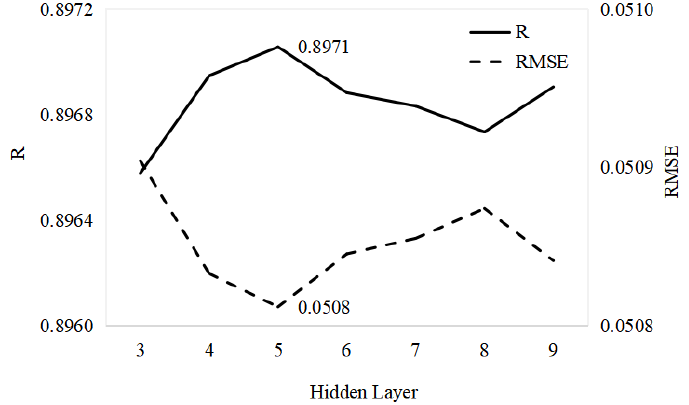
Figure 3. The RMSE and R of different hidden layers of the reconstructed NDVI model based on GA-ANN.